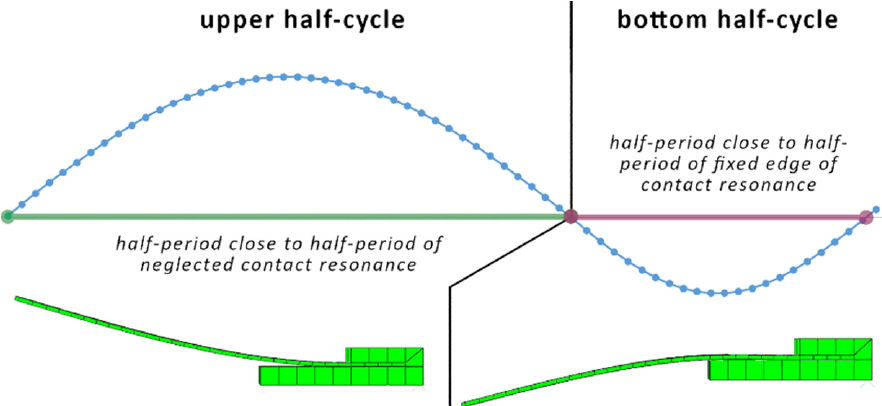
Figure 1. Illustration of two half-cycles on example of a nonlinear response vibration period. Opened contact at left and closed contact at right side